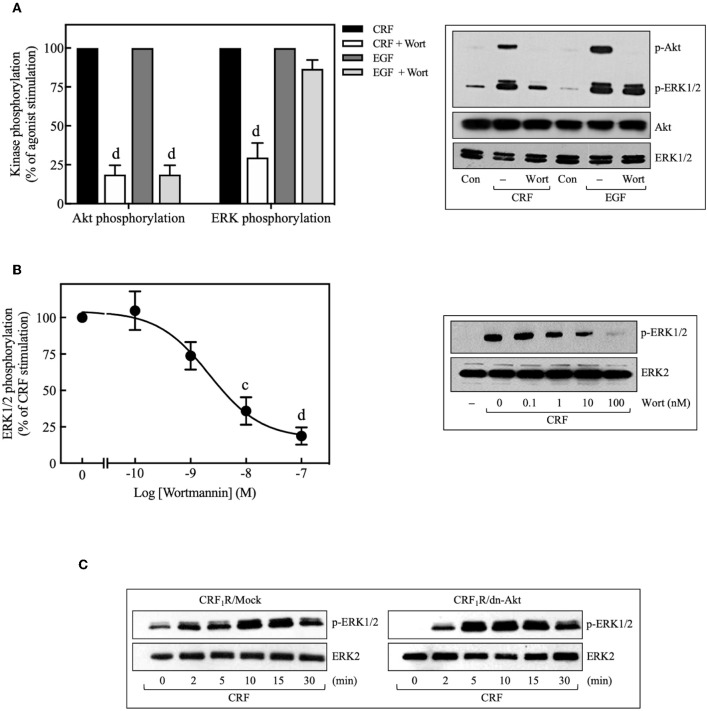
Involvement of the PI3K pathway in CRF-stimulated ERK1/2 phosphorylation. (A,B) COS-7 cells expressing HA-CRF1Rs were pretreated with 100 nM or the indicated concentrations of wortmannin (Wort) for 30 min before stimulation with 100 nM CRF for 5 min (A,B) or 10 ng/ml EGF for 10 min (A). (C) COS-7 cells co-transfected with a dominant-negative Akt (K179M) expression vector (dn-Akt) or an empty control vector (Mock) and the pcDNA3-HA-CRF1R expression vector were stimulated with 100 nM CRF for the indicated times. Total cell lysates were separated by SDS-PAGE and analyzed by immunoblotting with anti-p-Akt Ser473
(A) or anti-p-ERK1/2 Thr202/Tyr204
(A–C), as described in Materials and Methods. Akt and ERK1/2 phosphorylation were quantitated by densitometry, and mean values were plotted from three to five independent experiments. Vertical lines represent the S.E.M. Western blots were also probed for total Akt or ERK showing equal loading. (A)
dp < 0.0001 vs. CRF (p-Akt), dp < 0.0001 vs. EGF (p-Akt); dp < 0.0001 vs. CRF (p-ERK), (B)
cp < 0.001, dp < 0.0001 vs. 0 M.